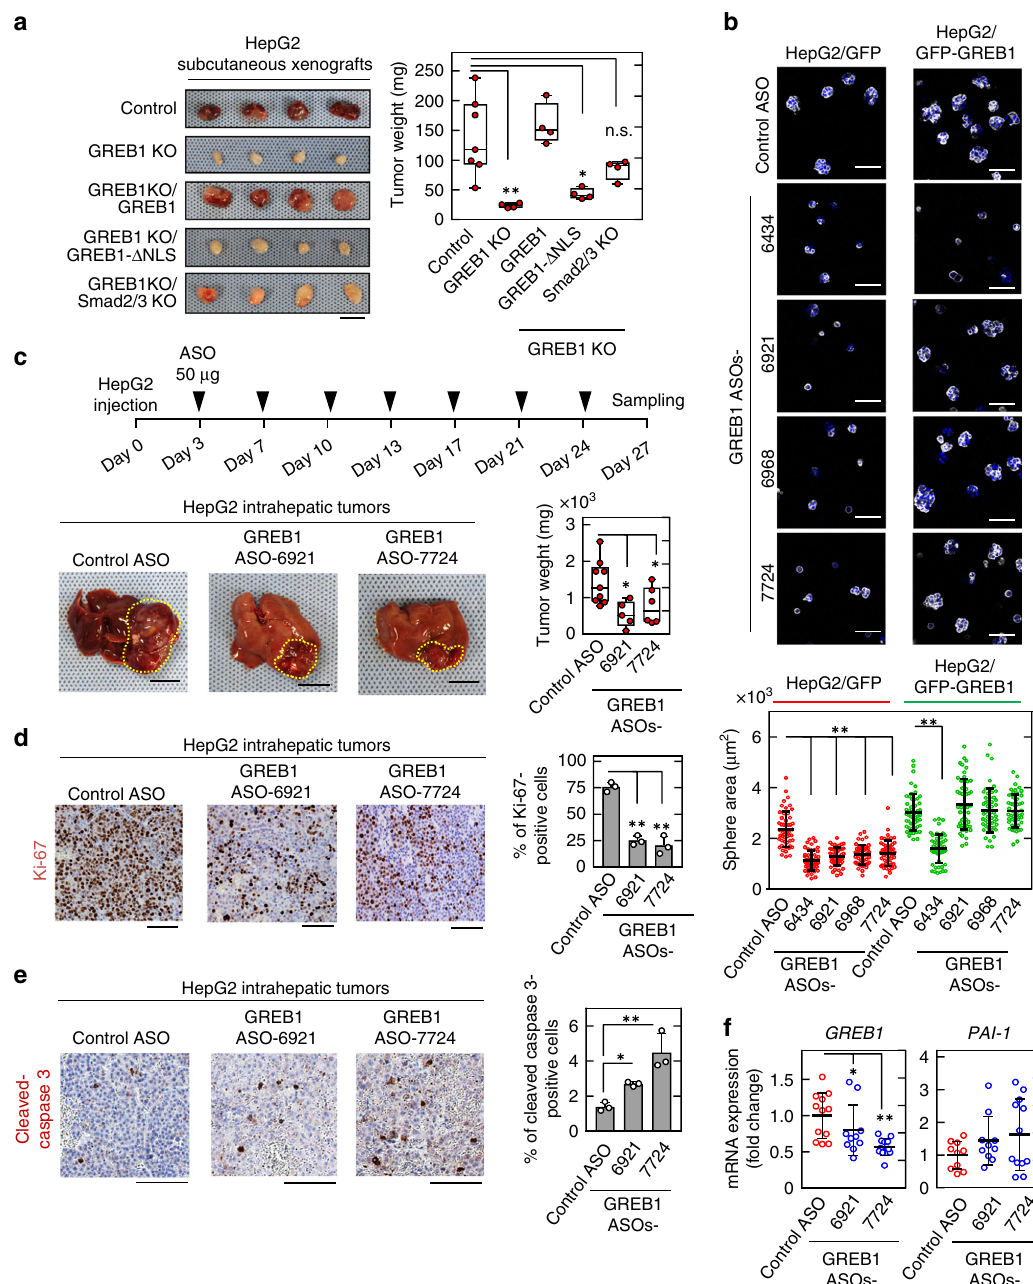
Fig. 8 GREB1 ASOs inhibit HB cell-induced tumor formation. a , Control, GREB1 KO expressing the indicated proteins, or GREB1 and Smad2/3 double KO HepG2 cells were subcutaneously implanted into nude mice ( n = 4). After 27 days, the mice were euthanized. Representative appearances of extirpated xenograft tumors are shown. Weights of the xenograft tumors were measured and the results are shown as box plots. ** P < 0.01; * P < 0.05, ANOVA and post hoc test. b HepG2 cells transfected with control or indicated GREB1 ASOs were cultured for 4 days in 3D Matrigel. Cells were stained with phalloidin and Hoechst33342, and areas of spheres were calculated. Results are shown as scatter plots with means ± SD ( n = 50). ** P < 0.01, ANOVA and post hoc test. c HepG2 cells were implanted with Matrigel into the livers of nude mice on day 0. Starting from day 3, control ASO ( n = 9), GREB1 ASO-6921 ( n = 5), or GREB1 ASO-7724 ( n = 6) was administered subcutaneously twice a week. Representative images of the liver tumors are shown. Weights of the xenograft tumors were measured and the results are shown as box plots. The yellow dotted lines indicate the outline of the tumors. * P < 0.05, ANOVA and post hoc test. d , e Sections from HepG2-induced liver tumors treated with control or GREB1 ASOs were stained with anti-Ki-67 ( d ) or anti-cleaved caspase 3 ( e ) antibody and hematoxylin. Ki-67 or cleaved caspase 3-positive cells were counted, and results are expressed as the percentage of positively stained cells compared with the total number of cells. ** P < 0.01; * P < 0.05, ANOVA and post hoc test. f Real-time PCR experiments for indicated mRNA expression in liver tumors were performed. Results are shown as dot plots with median ± SD. ** P < 0.01; * P < 0.05, ANOVA and post hoc test. Box-plot elements are de fi ned as follows; median is represented by the line, the box represents the 25 – 75th percentiles, and the whiskers go down to the smallest value and up to the largest. Scale bars in a and c , 1 cm; in b , d , and e , 100 μ m